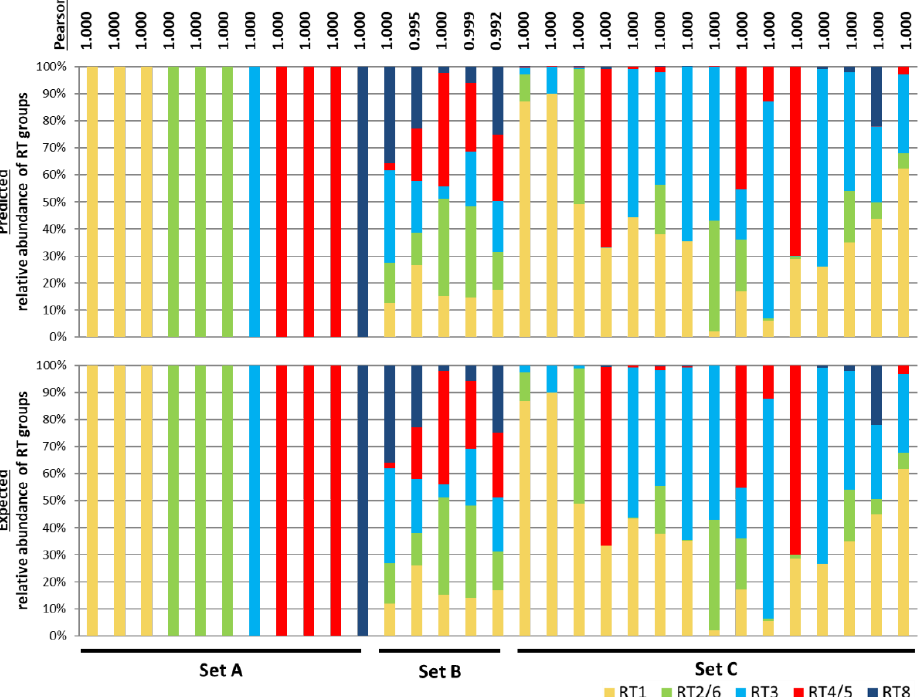
Figure 1. The strain composition predicted by STRUCTURE is highly consistent with the expected P. acnes populations based on simulated data. The top panel shows the ribotype (RT) group composition predicted by STRUCTURE based on the simulated communities. The bottom panel shows the expected RT group composition. Each column represents the relative abundances of the RT groups in each sample. The expected composition of each simulated community is listed in Table S2. Set A communities were generated to contain a single RT group per sample. Set B communities were generated to randomly have varying relative abundances of the RT groups. Five representative samples among the total 100 simulated communities are shown. Figure S2 lists all 100 communities of Set B. Set C communities were generated to mimic the population structures from previously characterized clinical skin samples [5]. Pearson’s correlations were calculated to compare the predicted population composition with the expected data as shown on the top.